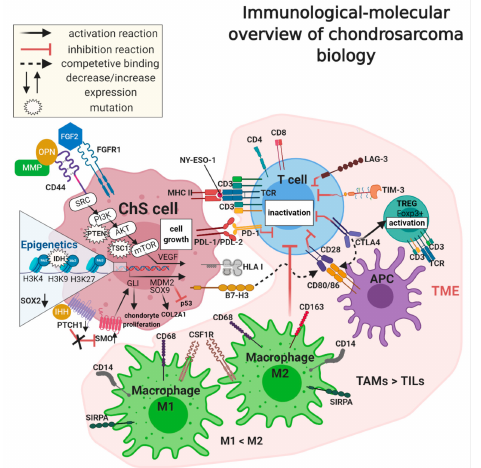
Figure 2. Immunological-molecular overview of chondrosarcoma (ChS) biology. Immune cell markers (PDL-1/2, B7-H3, and MHC), mesenchymal stem cell markers (CD44), and the tumor mi- croenvironment (TME), in which the primary role is played by tumor-infiltrating lymphocytes (TILs) and tumor-associated macrophages (TAMs), especially the M2 type, participate in ChS pathogenesis and immunosuppression. Other important factors involved in ChS progression are deregulations in molecular pathways (PI3K/AKT/mTOR and hedgehog), epigenetic modifications (trimethyla- tion of H3K4, H3K9, H3K27), and gene mutations ( PTEN , TSC1 , IDH ), which together characterize the